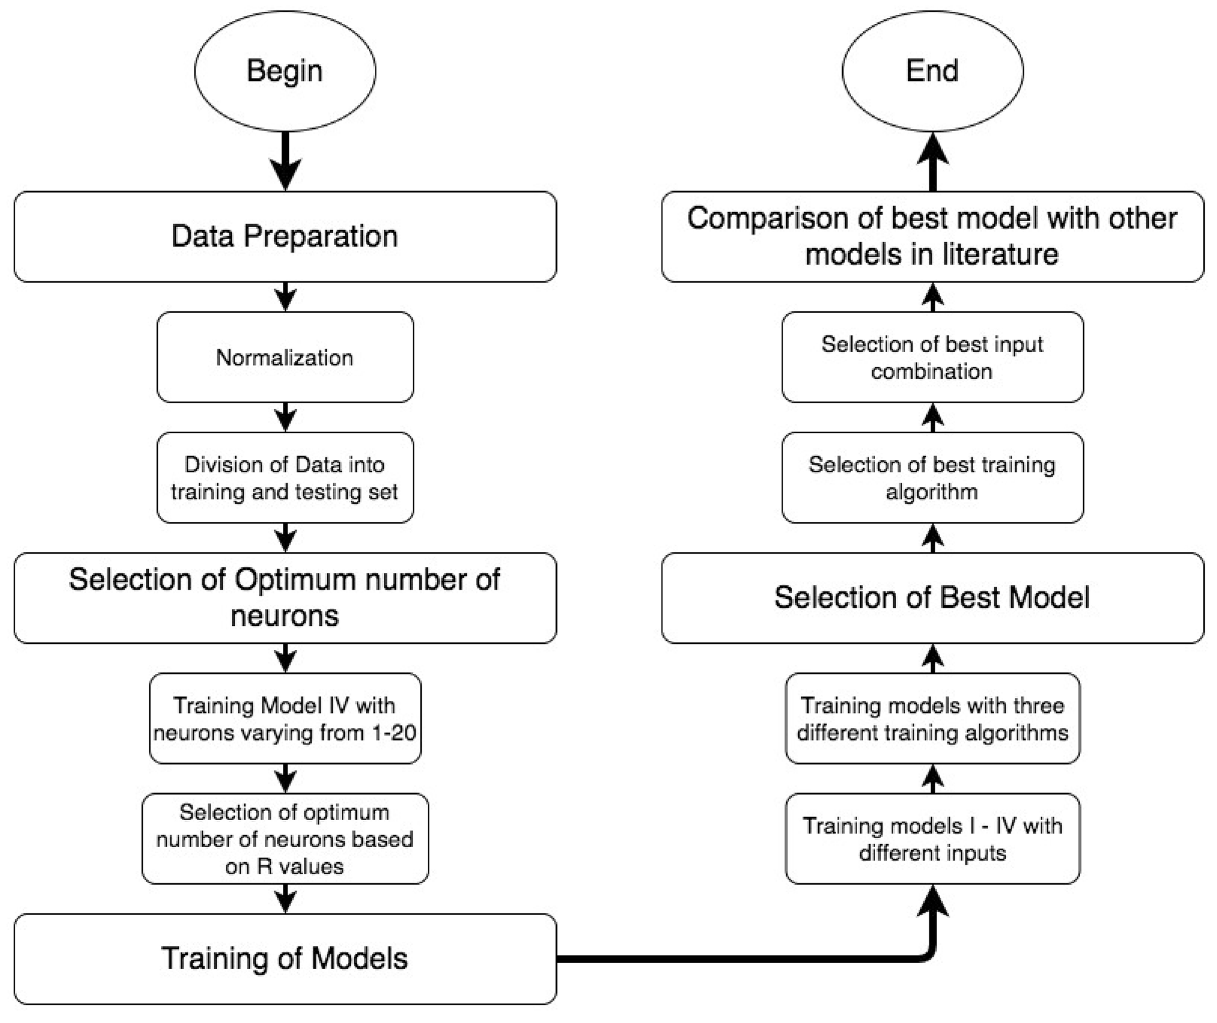
Figure 1. Flow chart of